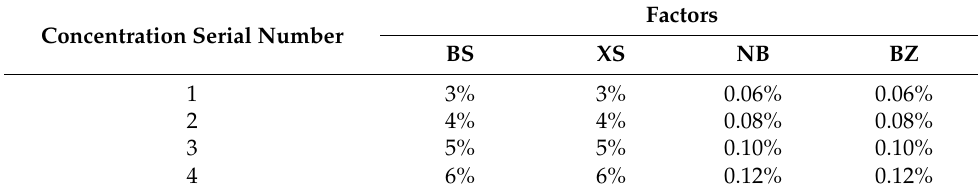
Table 1. Factor concentration level table. Concentration Serial